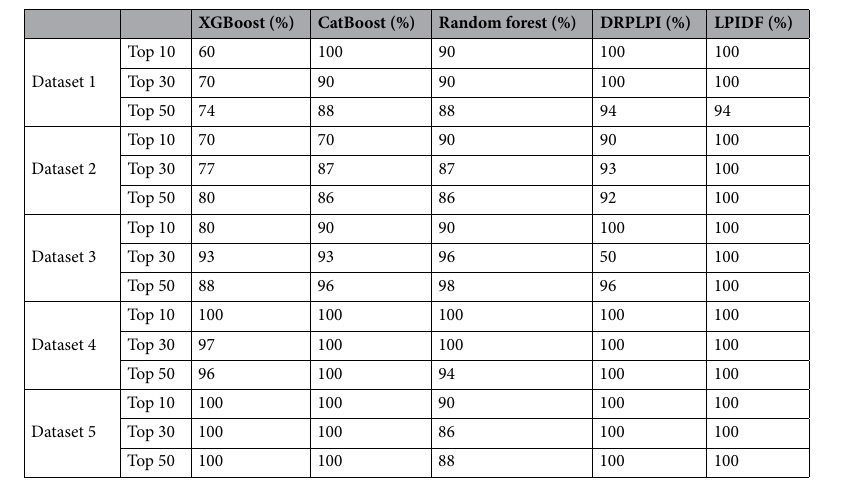
Table 8. The fractions of true LPIs among the top N interactions under CV3.